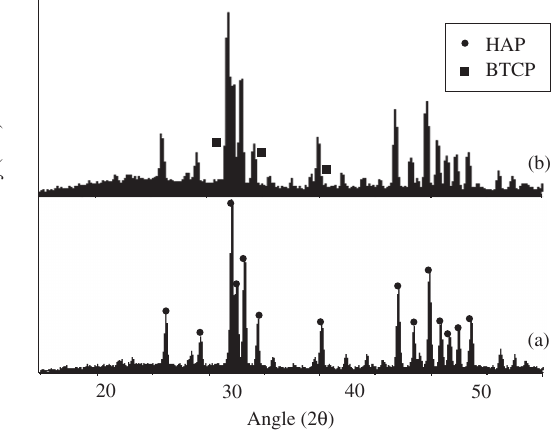
Figure 5. XRD spectrum of HAP/COL composite showing characteristic peaks of pure hydroxyapatite and the presence of amorphous material (a), XRD spectrum of HAP b TCP/COL showing the presence of two crystalline phases, hydroxyapatite (HAP) and a smaller amount of b -tricalcium phos- phate ( b TCP) (b).